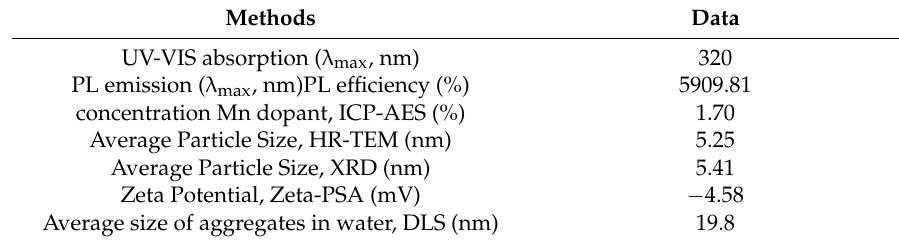
Table 2. Experimental data summary of ZnS:Mn-Asp NCs. (ICP-AES: inductively couples